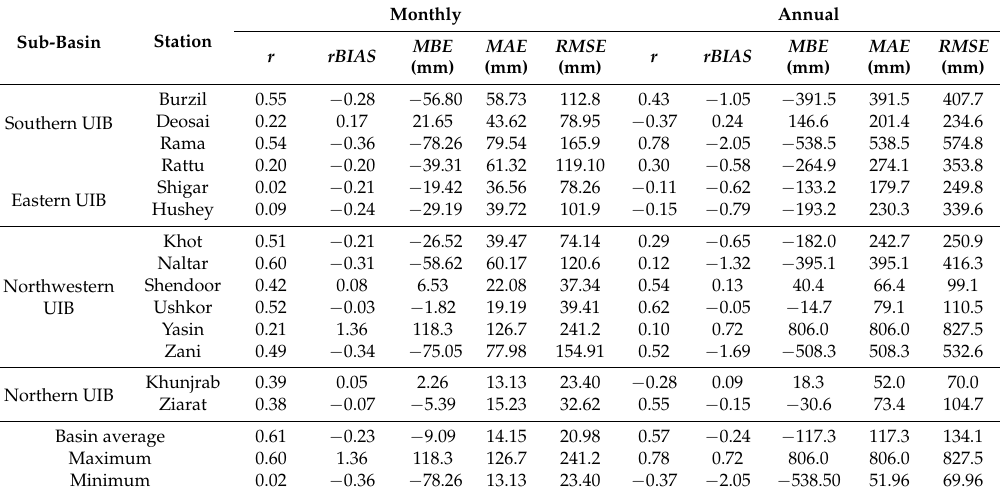
Table 4. Statistical analysis based on monthly and annual data